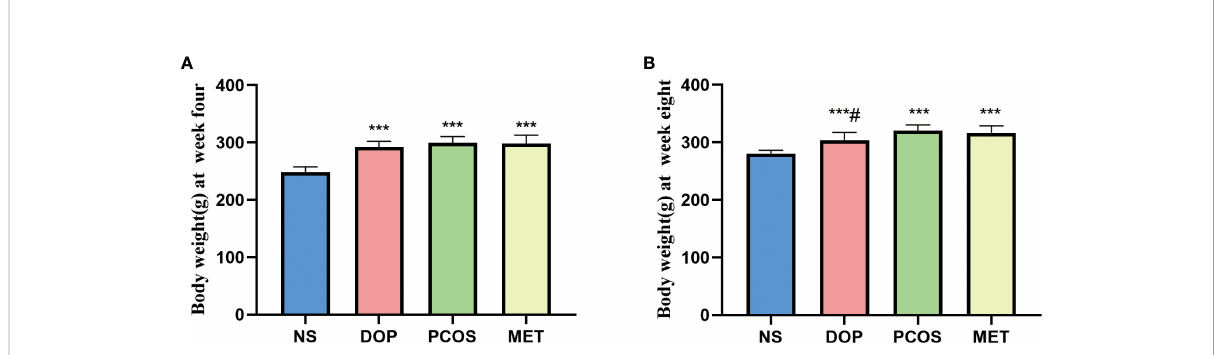
FIGURE 1 Effects of DOP treatment on body weight in rats, n = 6. Note: compared with the NS group, *** p < 0.001; compared with the PCOS group # p <